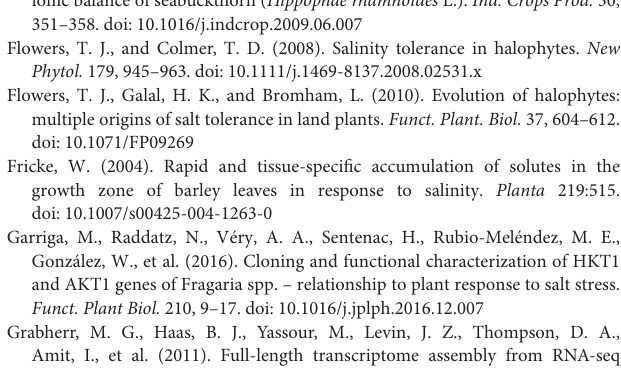
attributable to its greater growth rate and higher water